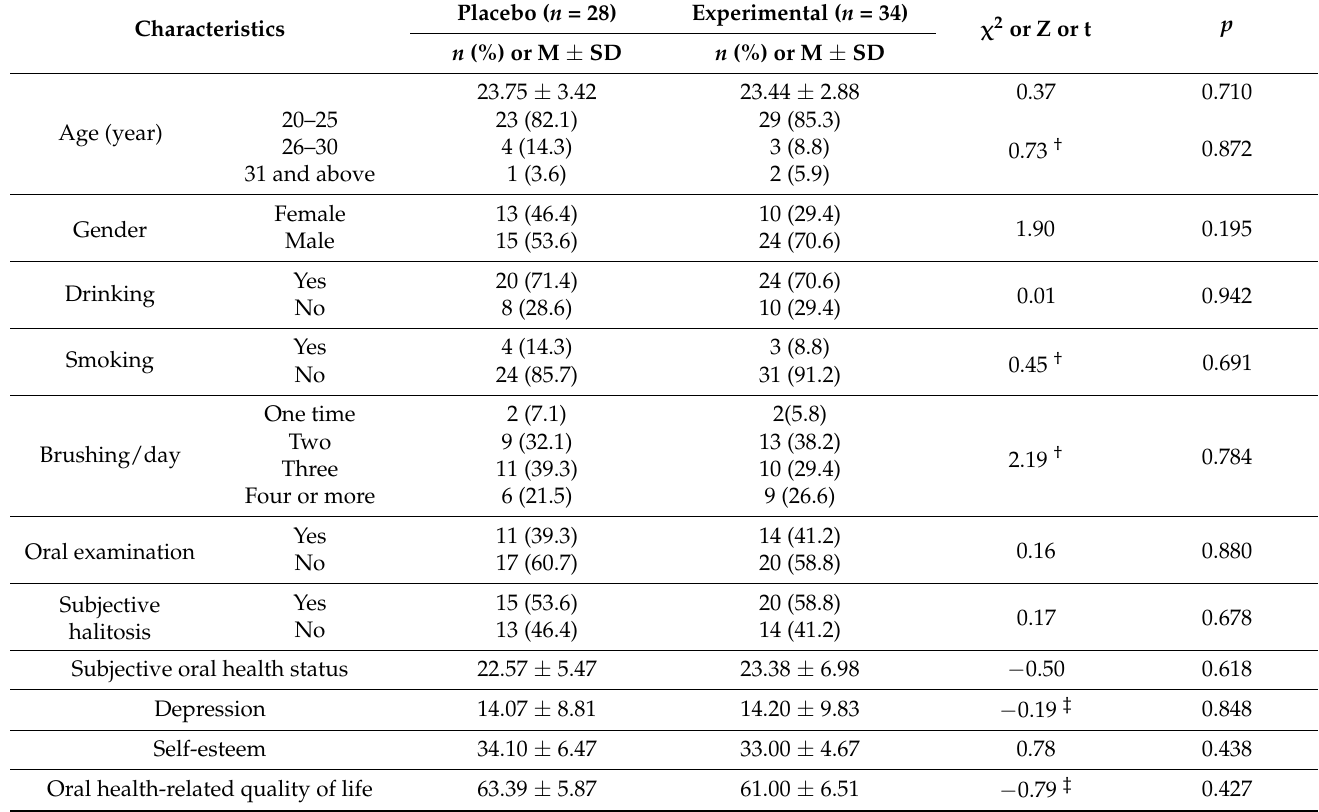
Table 1. Homogeneity of subjects’ general characteristics and dependent variables between the experimental and placebo groups before treatment ( n =